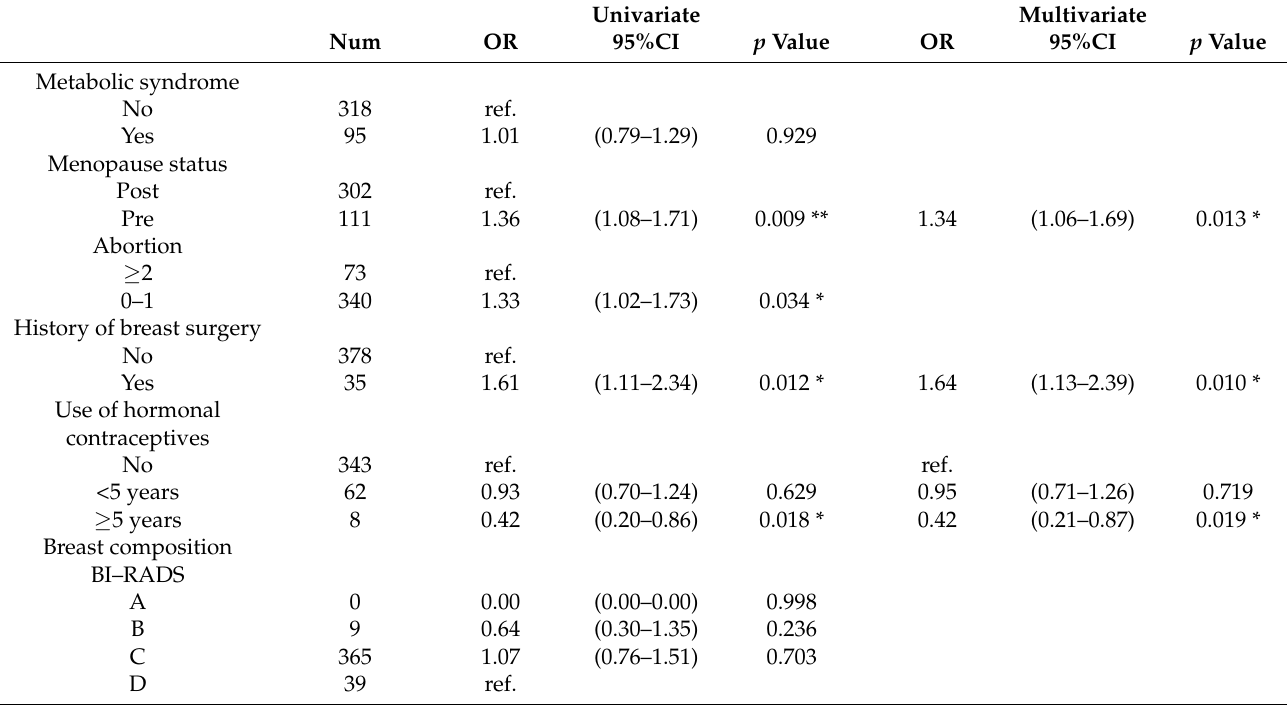
Table 2. Univariate and multivariate logistic regression analysis: independent variables assessed incomplete mammographic evaluation (BI-RADS category 0). Univariate